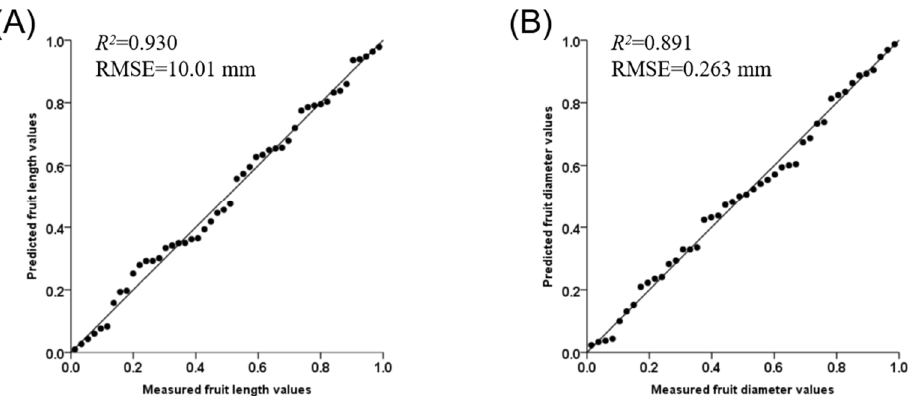
Figure 6. Comparison between predicted and measured values of cucumber fruit length ( A ) and diameter ( B ).